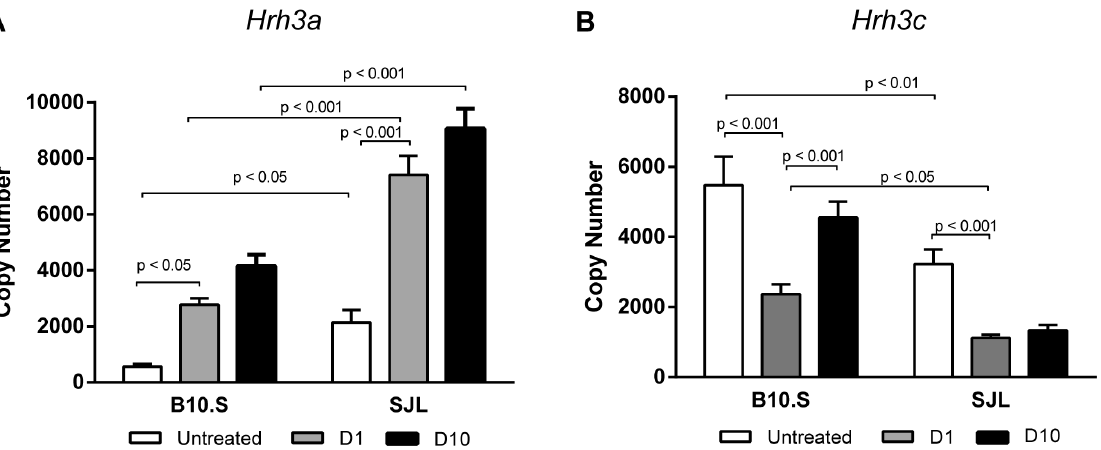
Figure 4. Differential Hrh3 isoform expression in B10.S and SJL mice in response to peripheral inflammatory stimuli. ( A ) Hrh3a expression in the forebrain of B10.S and SJL mice (n=20), as determined by qRT-PCR (see Materials and Methods), either untreated, or D1 and D10 post-treatment. ( B ) Hrh3c expression in the forebrain of B10.S and SJL mice, untreated, or D1 and D10 post-treatment. Data were analyzed by two- way ANOVA for effect of treatment and strain.